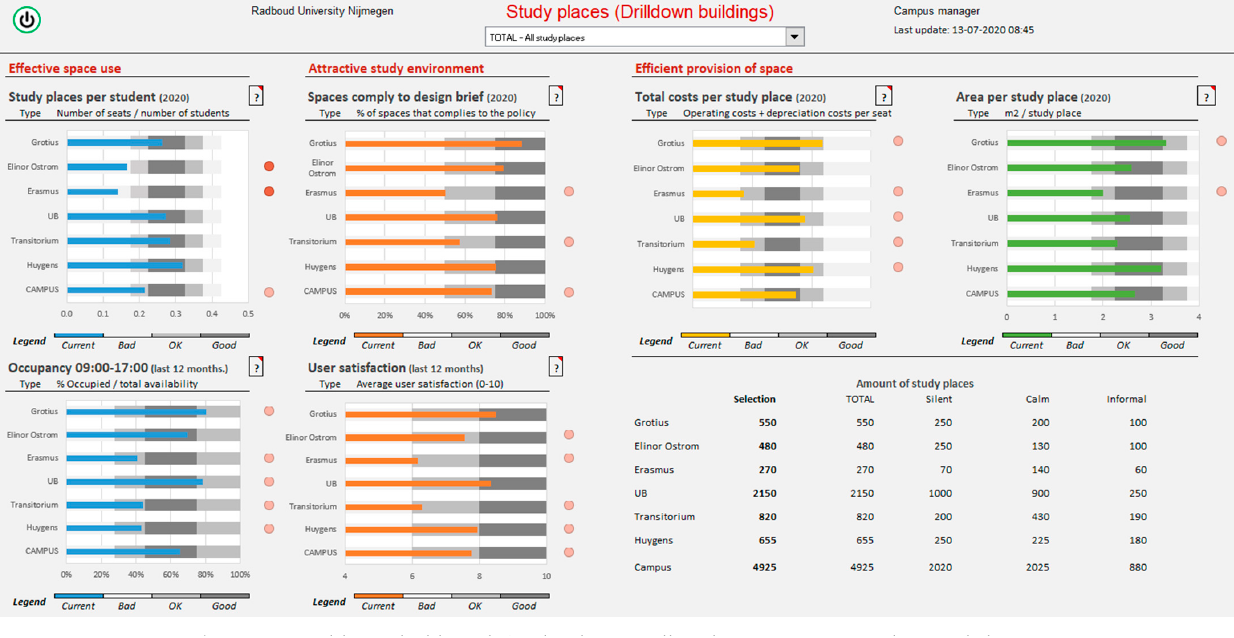
Figure A2. Drilldown dashboard ‘Study places Radboud University’ (tested in workshop 2).